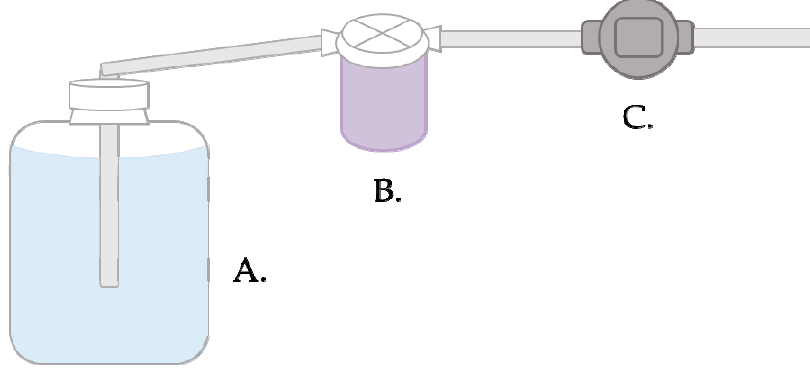
Figure 2. Filtration setup and water flow diagram. One end of tubing is placed in the water sample ( A ) and connected on the other end to the filter housing unit ( B ). Water is pulled through the filter in the housing unit and another piece of connected tubing by the pump at a maximum flow rate of 8.5 L/minute ( C ). Water is discarded through the final piece of tubing.